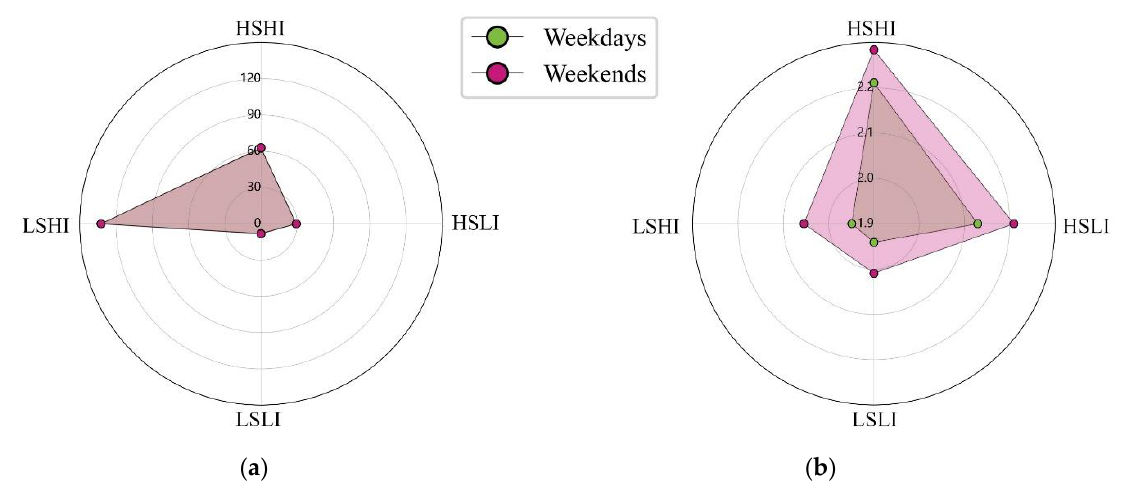
Figure 10. Comparison of the dynamic evaluation index of street vitality types on weekdays and weekends. ( a ) Vitality intensity; ( b ) Vitality stability.